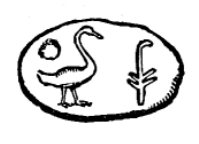
Figure 1. Front cover motif from the first edition of She (1887)